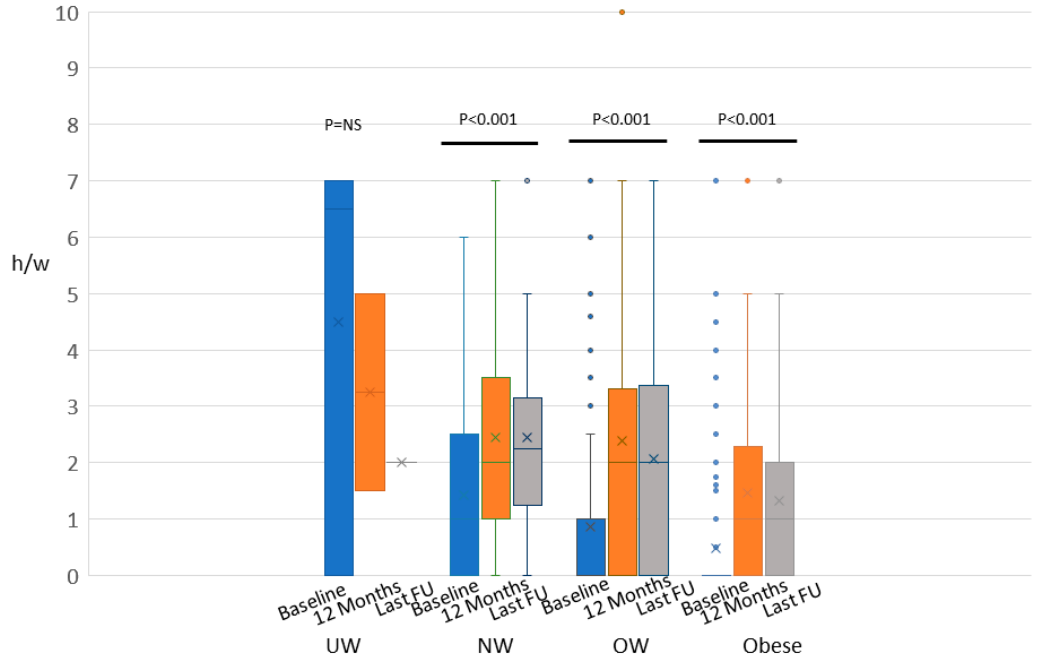
Figure 2. The figure represents the physical activity as hours per week (h/w) evaluation at the baseline (blue), at 12 months (orange) and at the end of the study (gray) in underweight (UW), normal weight (NW), overweight (OW) and obese patients by the whisker plot. The dots represent the outlier values. The estimated difference in physical activity along time-points was performed by means of ANOVA with repeated measures. No statistically significant differences ( p = NS) were seen in the UW group, whereas in the NW, OW, and obese groups, a statistically significant difference was shown ( p < 0.001).